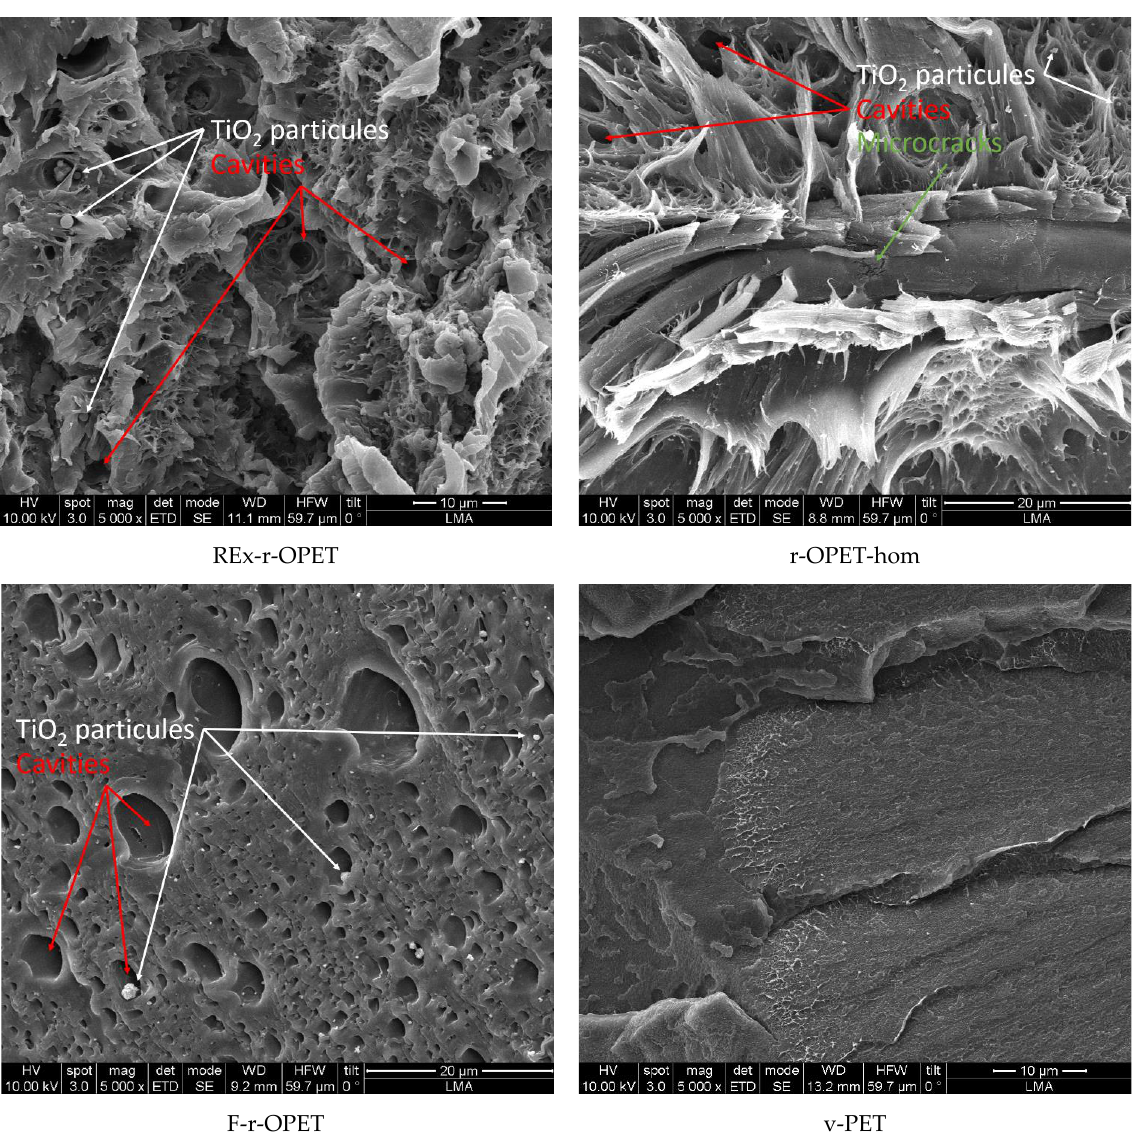
Figure 12. SEM images of fractured surfaces during T-T stressed at 95 %UTS (×5000) Moreover, by looking into the SEM images in Figure 13, the presence of TiO 2 particles is observed inside huge cavities, except for virgin PET. During ductile damage behaviour, microcracks appear in the matrix and at the interface between matrix and TiO 2 inclusions. Microcracks nucleate around inclusions, at the matrix/TiO 2 interface due to poor adhe- sion. With the rise of stresses, microcracks grow around nanoparticles. Nucleation and growth of microcracks is a thermodynamic phenomenon that produces heat. This heat is transferred to the matrix, changing its behaviour and allowing more deformation. Nano- particles can act as stress concentrators that form the void at multiple sites and finally promote the fracture process. Elongation seems stronger around the gaps, which would support the role of particles as stress concentrators.